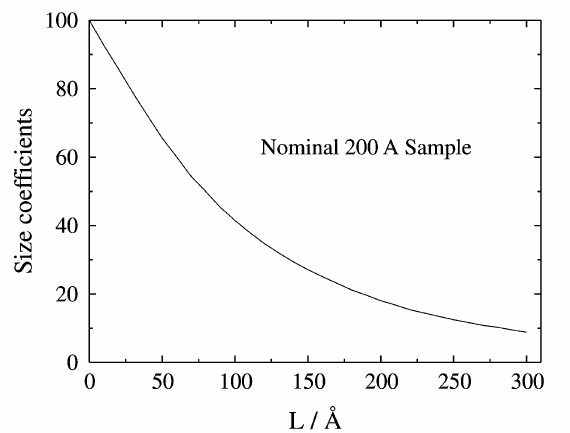
Figure 3. Size coefficients determined from the real part of the Fourier transform for family direction [0 1 0] for sample with nominal 200 Å crystallite size.